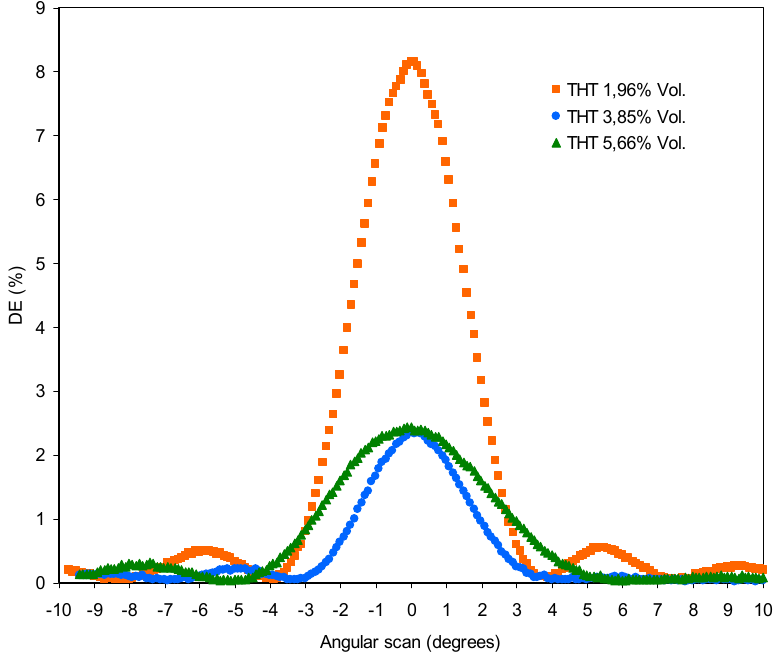
Figure 11. Diffraction efficiency versus angular scan for samples with polymer A and different concentrations of THT.